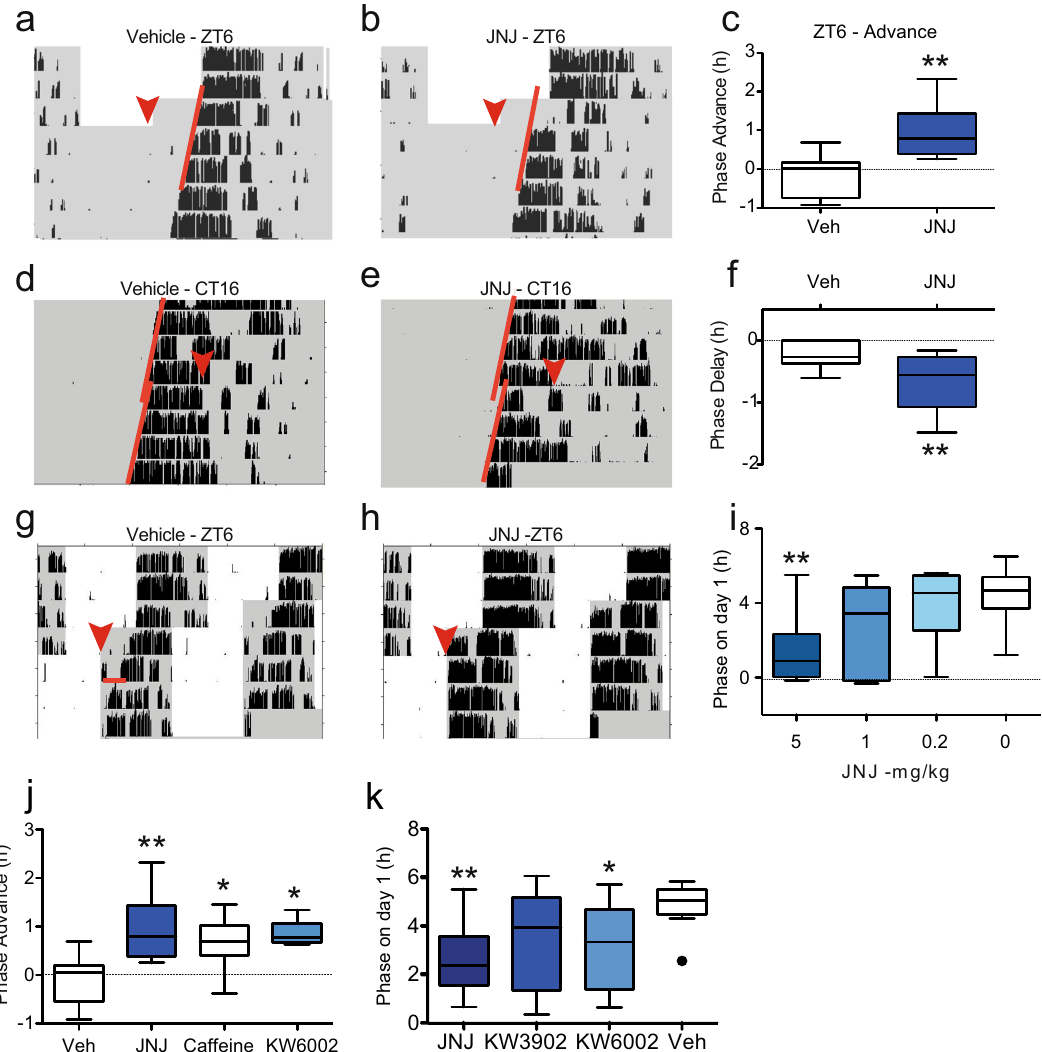
Fig. 4 A 2A /A 1 adenosine receptor antagonists modify circadian behaviour. a – c Mice were housed in 12:12 L:D cycle, (grey – dark, white – light, black vertical bars show wheel running activity). At the red arrow (ZT6), animals received an i.p. injection of a vehicle or b 5 mg/kg JNJ40255392 (JNJ) and released into constant dark (DD). Activity onset on subsequent days is indicated by red line and c phase shifts expressed as a Tukey ’ s box plot ( n = 12 and 8, ** = p = 0.0012, one-way ANOVA with Dunnett ’ s multiple comparisons test). d Mice were housed in DD (CT16) received either vehicle or e 5 mg/kg JNJ at red arrow (CT16) and f phase shifts measured ( n = 11 and 10, * p = 0.007, t -test). g – i Mice were housed in 12:12 LD received either g vehicle ( n = 12) or h JNJ at 5 ( n = 12), 1 ( n = 6) or 0.2 ( n = 6) mg/kg at ZT6 (red arrow) and LD cycle advanced by 6 h. The phase of activity was measured the